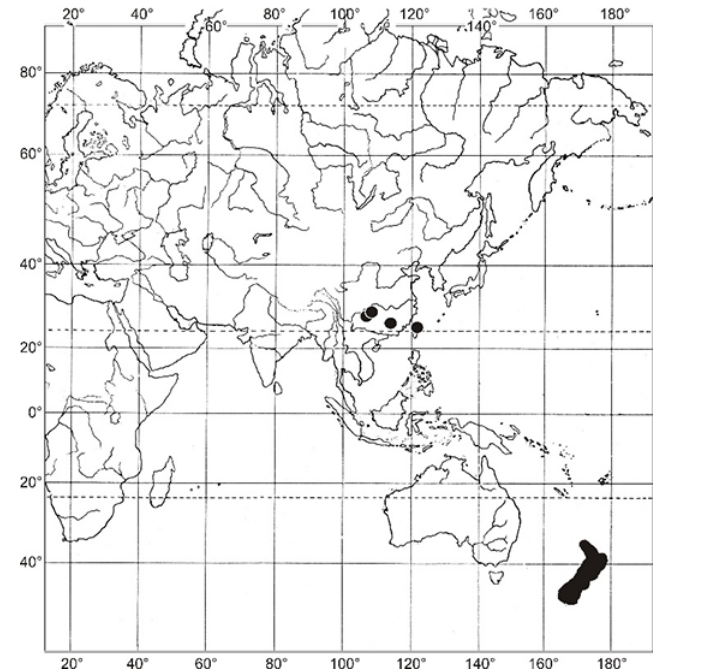
Figure 3 The global distribution of Lewinskya graphiomitria .